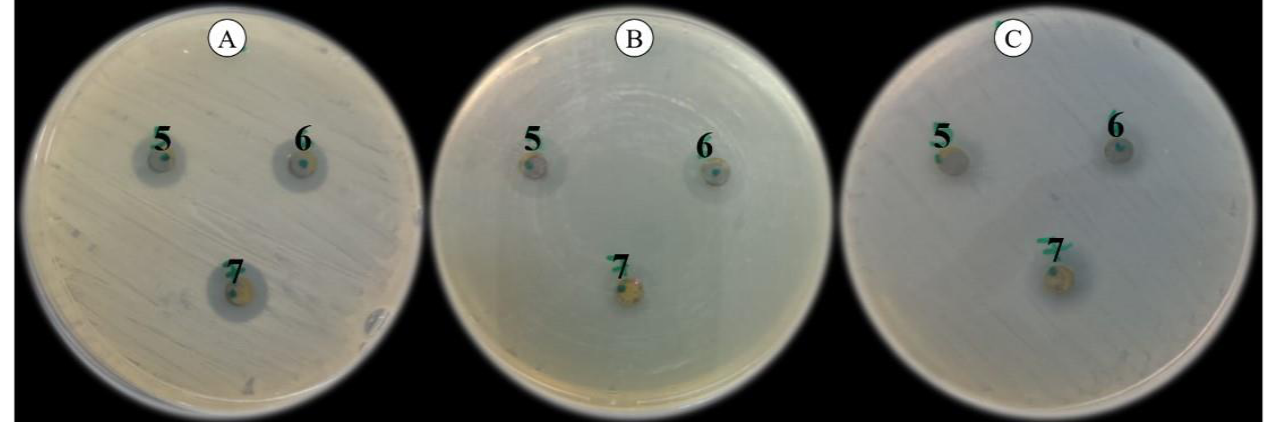
Figure 2. The results found by the agar diffusion method (ADM) were obtained from the leaf extracts of M. linifera — 5: hexane (HE); 6: dichloromethane (DE); and 7: chloroform (CE). ( A ) S. epidermidis ; ( B ) E. faecalis ; ( C ) S. aureus .